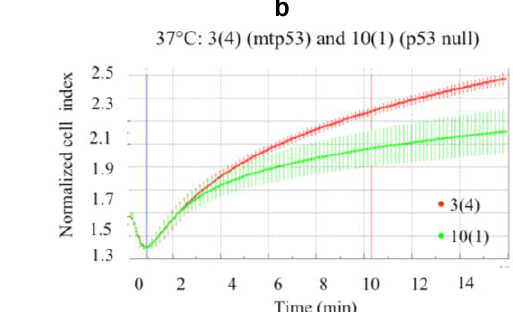
deformability. Average values and standard deviation at each time points are shown ( n = 4).